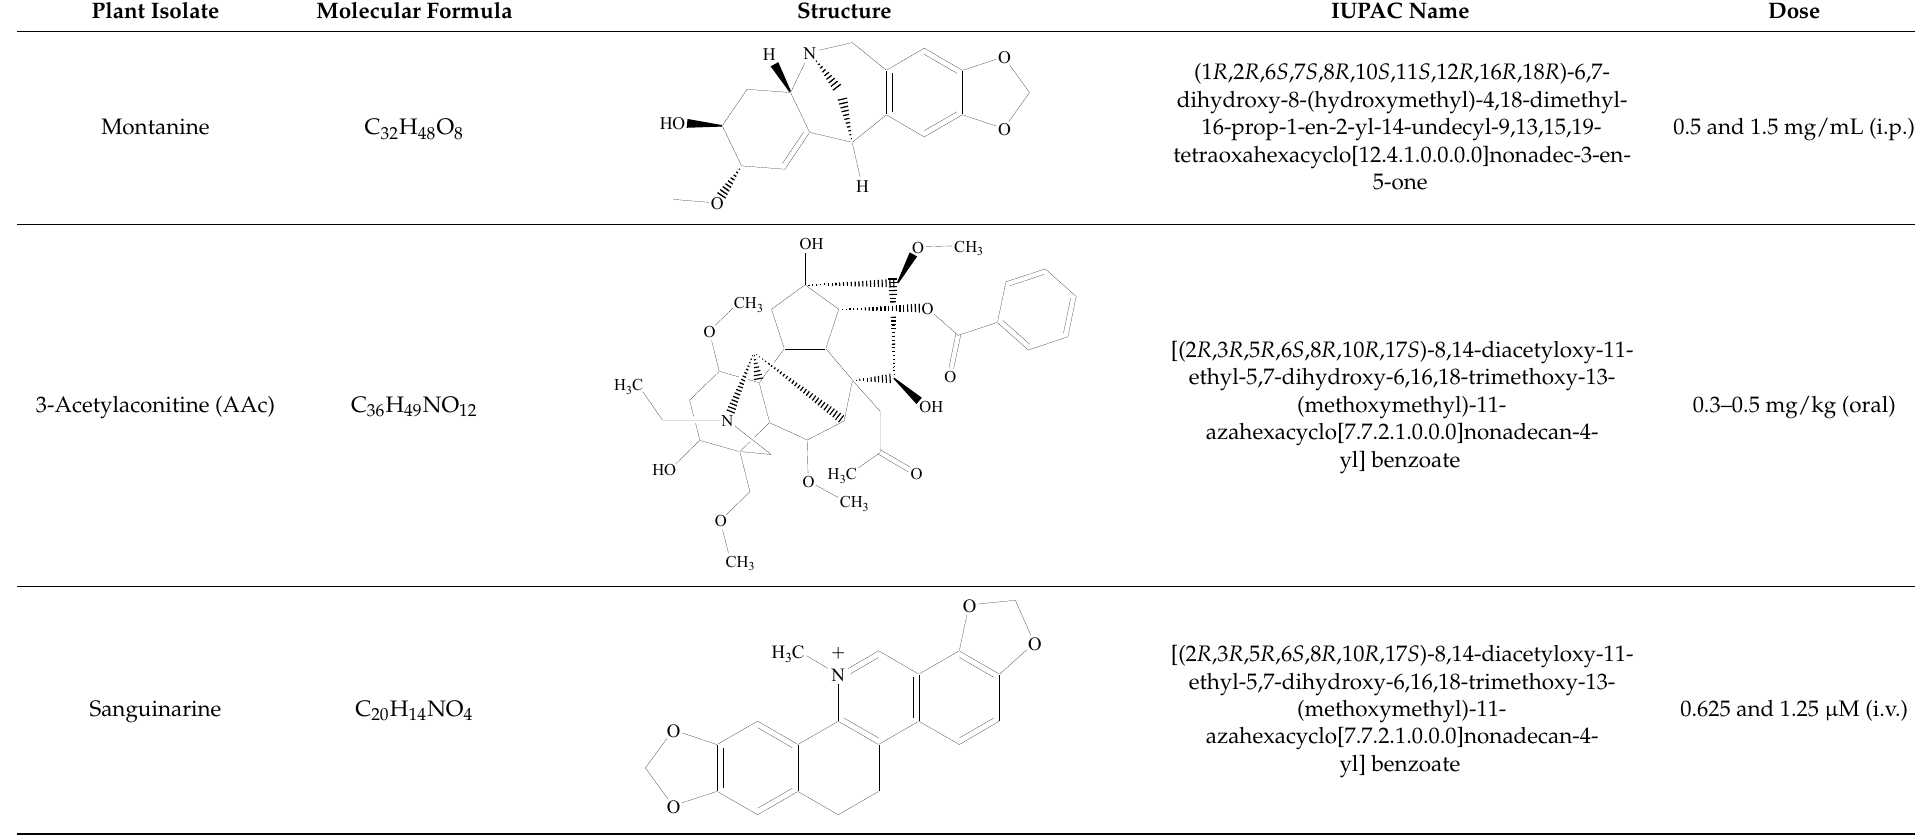
Table 1. List of herbal isolates with their molecular formula, structures, and IUPAC names.